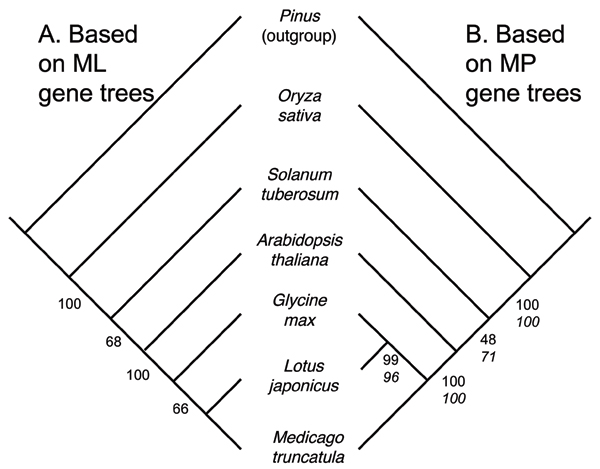
Species tree inferred by gene tree parsimony. A. The best species tree obtained using gene tree parsimony based on the maximum likelihood gene tree collection. It is identical to the accepted tree in Figure 2. B. The best species tree obtained using GTP based on the maximum parsimony gene tree collection. It differs from the accepted tree only within the legumes. Bootstrap II support values (resampling the gene trees: see text) are shown in plain text for each bipartition in the tree. Bootstrap I values (resampling the data within the original clusters) are shown in italics for tree B.